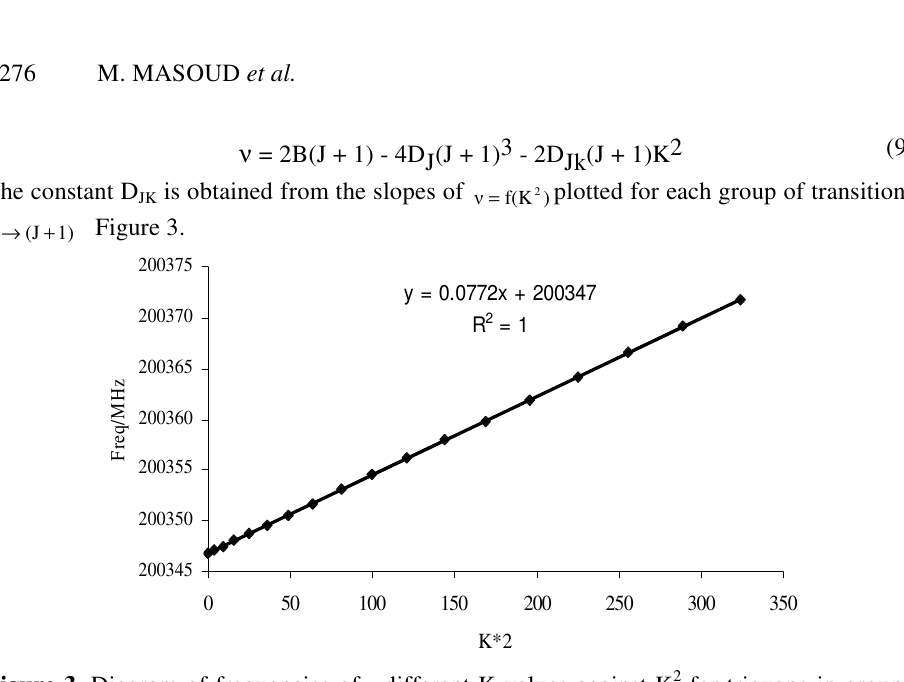
Figure 3. Diagram of frequencies of different K values against K 2 for trioxane in ground state, J =